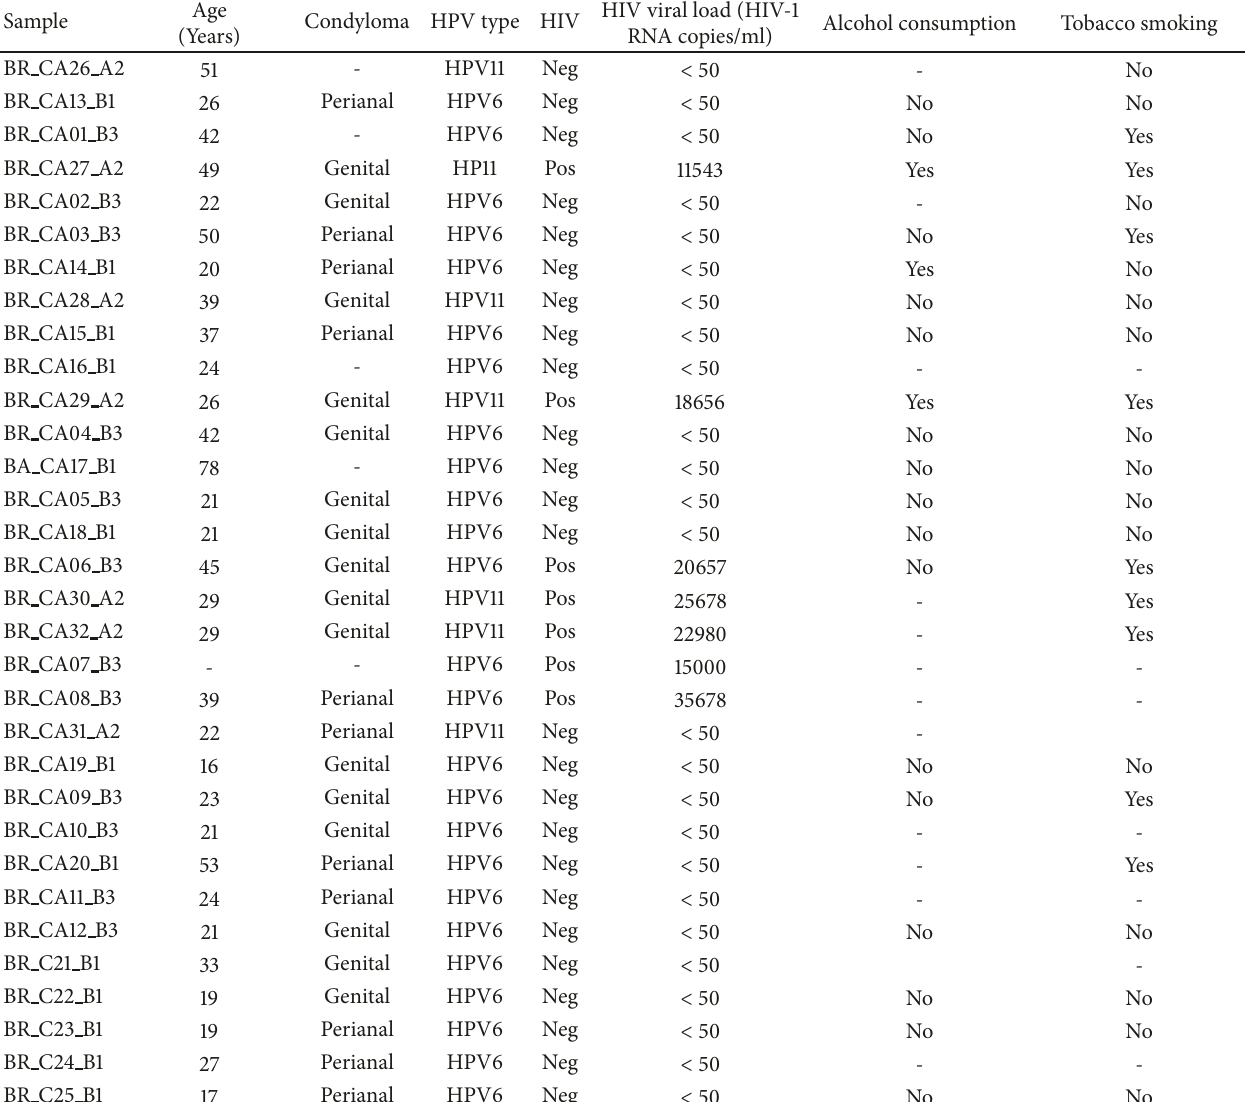
Table 1: Characterizationof the 32 samples regarding to the factors age, lesion, HIV coinfection, alcohol consumption, and tobacco smoking.